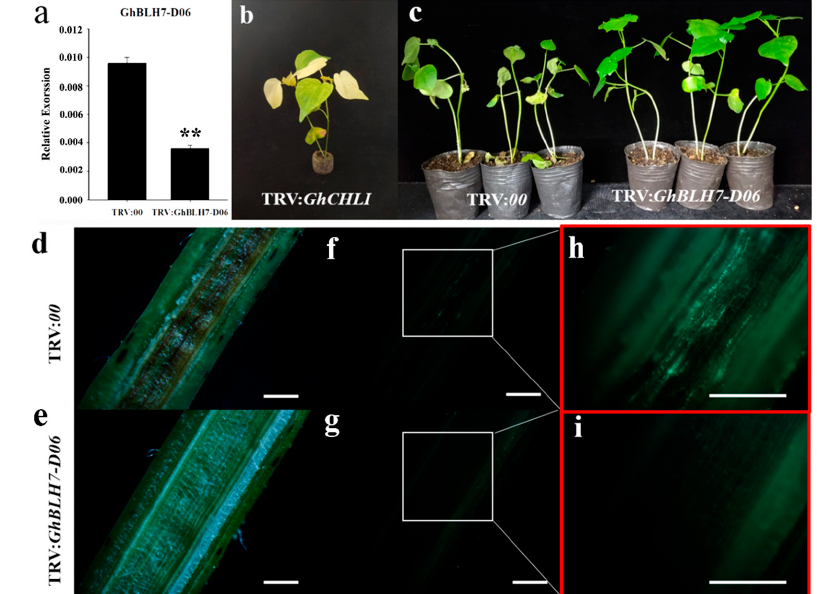
Figure 3. Phenotypic identification and analysis of GhBLH7-D06 VIGS cotton: ( a ) silencing efficiency of VIGS test of GhBLH7-D06 ; ( b ) phenotype of VIGS positive control plants; ( c ) phenotype observation of GhBLH7-D06 VIGS plants and wild type control plants after two weeks of V. dahliae ( Vd991-GFP ) infection; and ( d – i ) observation of epicotyl longitudinal sections of GhBLH7-D06 -silenced plants and control plants, Scale bars = 1.0 mm. Error bars represent the standard deviation of three biological replicates. Asterisks indicate statistically significant differences, as determined by Student’s t -test (* p < 0.05; ** p < 0.01).